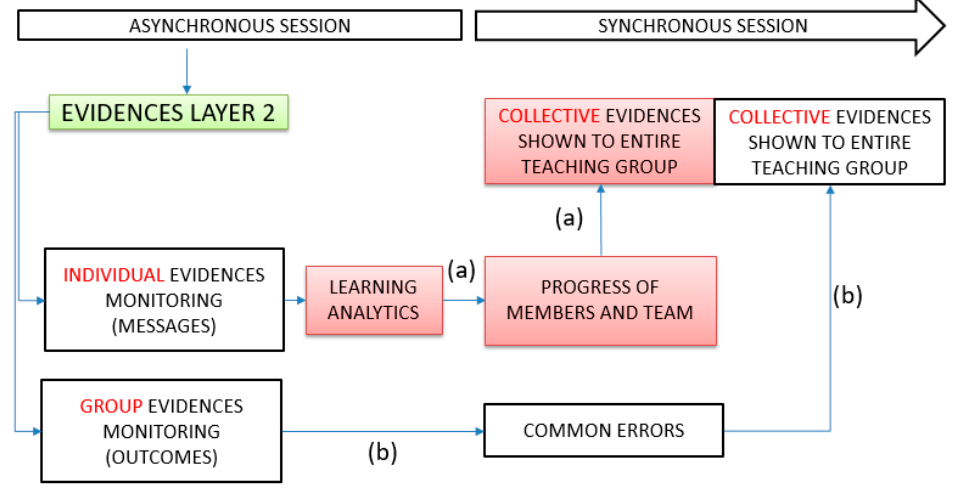
Figure 3. Functional model of layer 3.